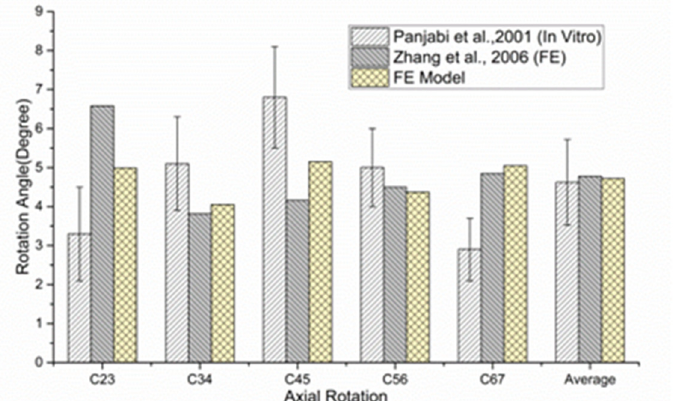
Figure 4. Comparison of ROM under lateral bending moment of 1.0 Nm (data from [1,18]).